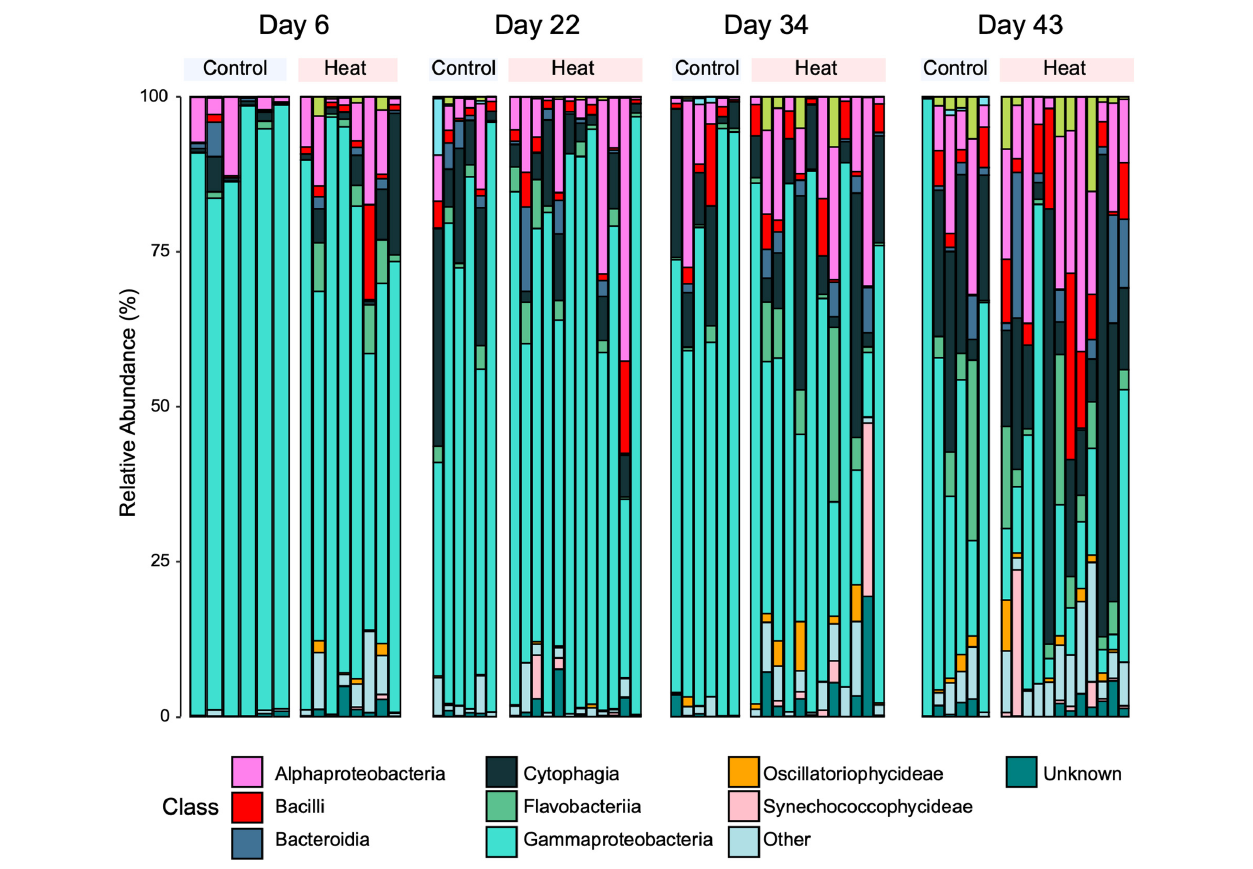
FIGURE 5 | Relative percent abundance of ASVs in the community microbiome, sorted into top 10 bacterial classes. Samples are grouped into treatment by